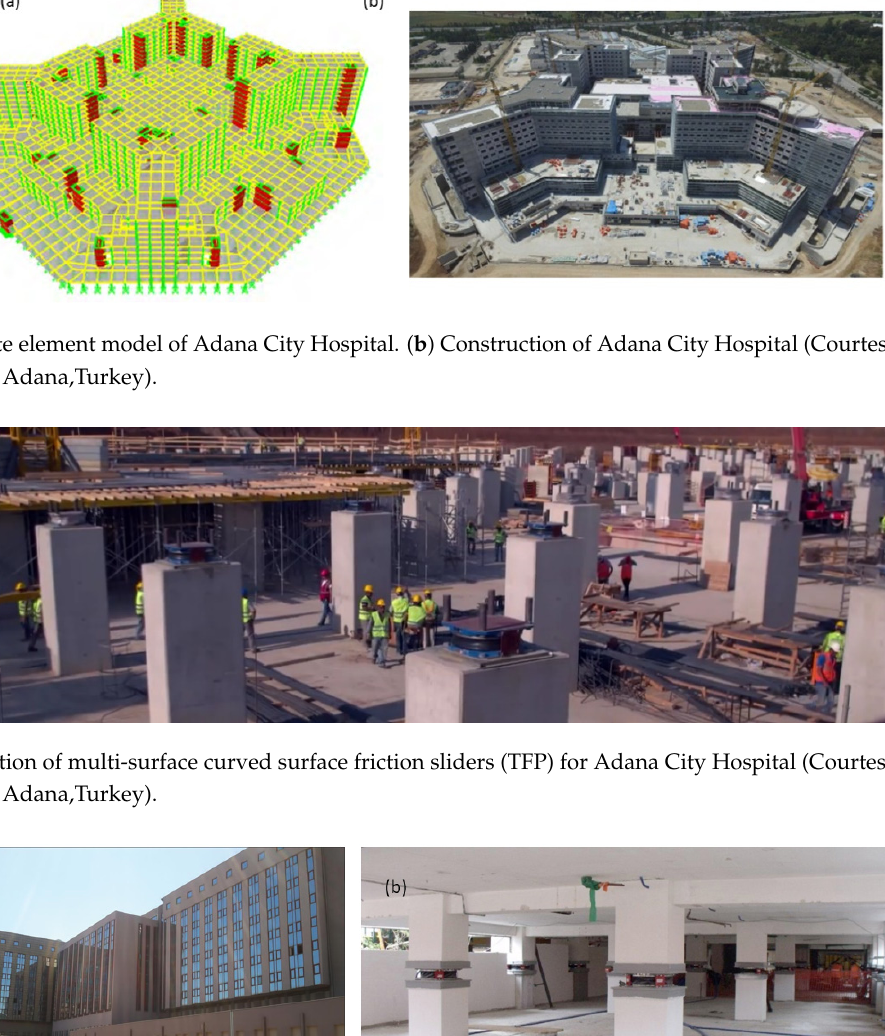
Figure 33. ( a ) Finite element model of Adana City Hospital. ( b ) Construction of Adana City Hospi- tal (Courtesy of Rönesans Construction Inc.).